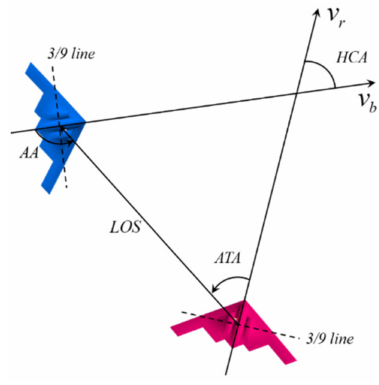
Figure 2. Geometry of air